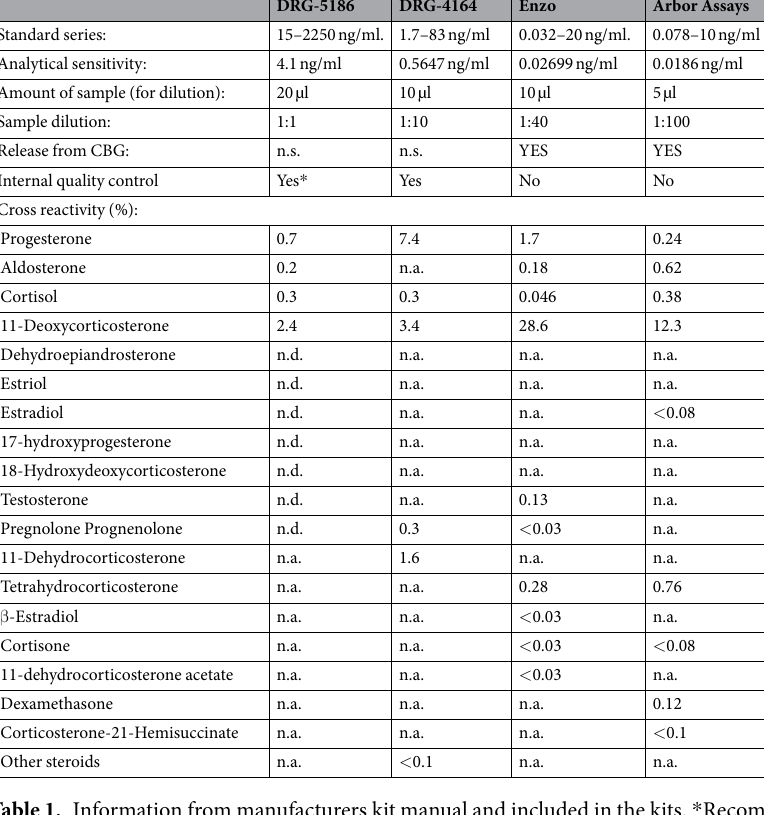
The Kruskal-Wallis test showed a significant difference between kits (H(3, N = 128) = 84.66, p = 0.000). The Arbor Assays kit yielded the highest mean corticosterone values and the largest variance (357.75 ± 210.52). This was significantly higher than both the DRG-5186 (40.25 ± 39.81) and the Enzo kit (66.27 ± 51.48), p = 0.0000 for both comparisons and close to significantly higher than the DRG-4156 kit (183.48 ± 108.02, p = 0.0596). The DRG-4164 assay showed significantly higher corticosterone values compared to the Enzo and DRG-5186 kits (p’s < 0.0004 and 0.0000 respectively). There was no significant difference between corticosterone values meas- ured by the ENZO kit and the DRG-5186 kit. See Fig. 1. Spearman Rank Order Correlations showed that all results from the various assay kits (n = 32 for each assay) were positively correlated (p’s < 0.05): DRG-5186 vs Enzo (r = 0.95); DRG-5186 vs DRG-4164 (r = 0.95); DRG- 5186 and Arbor Assays (r = 0.88); Enzo vs DRG-4164 assay (r = 0.93); Enzo vs Arbor Assays (r = 0.84) and DRG- 4164 vs Arbor Assays (r = 0.84).